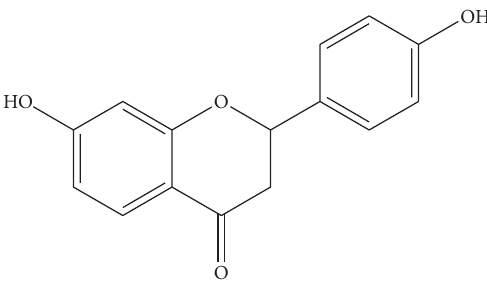
Figure 1: Molecular structure of